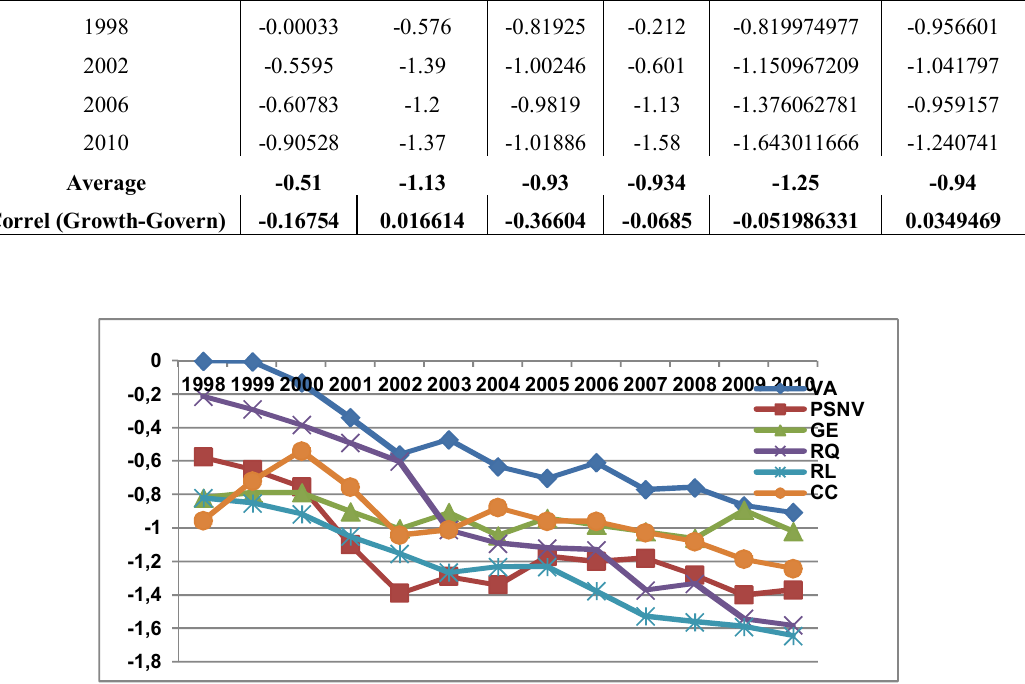
Figure 11: Governance Indicators of Venezuela over